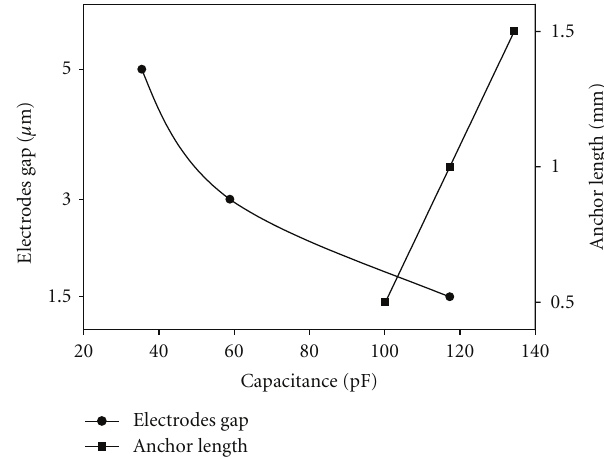
Figure 11: Nominal capacitance comparisons for electrode gap and anchor